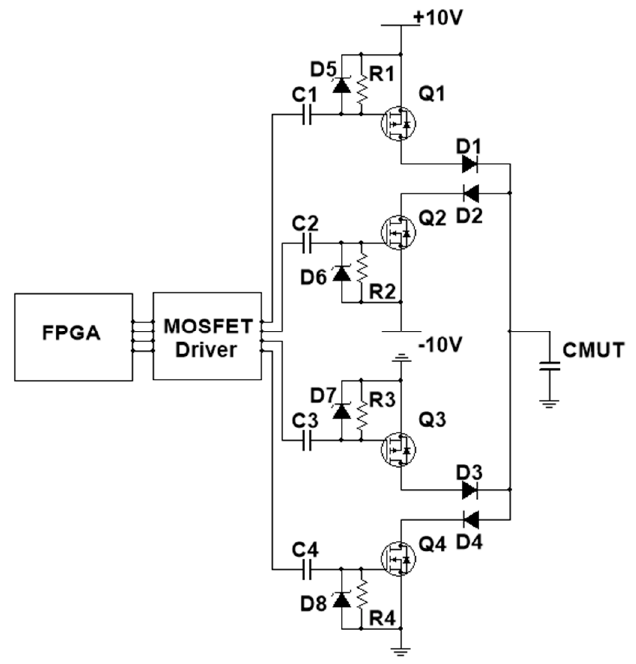
Figure 2. Circuit design of the bipolar square-wave pulser.